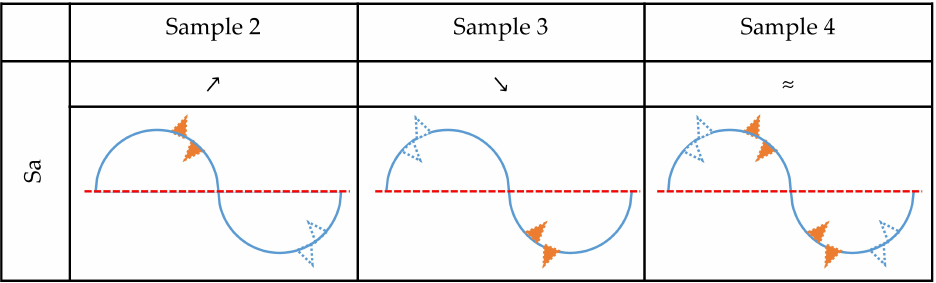
9Figure 9. Determination of dominant corrosion effects that correlate with changes of parameter Sa. Figure The empty blue triangle represents material loss while the orange filled triangle represents material gain. Results of paired t test are symbolically represented by symbols ≈ , (cid:37) , (cid:38) . These symbols represent insignificant difference, significant increase, and significant decrease in specific parameters,